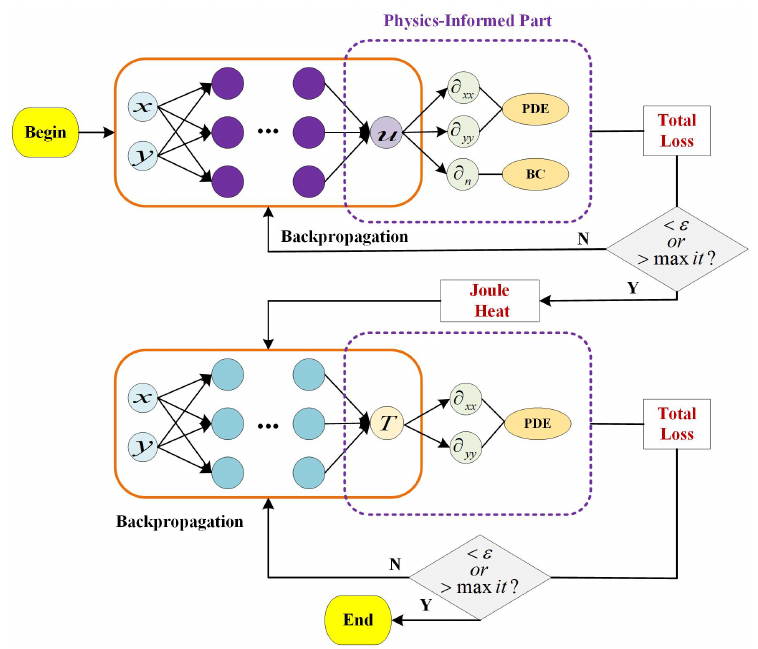
Figure 3. The flow diagram of electro-thermal coupling computation based on